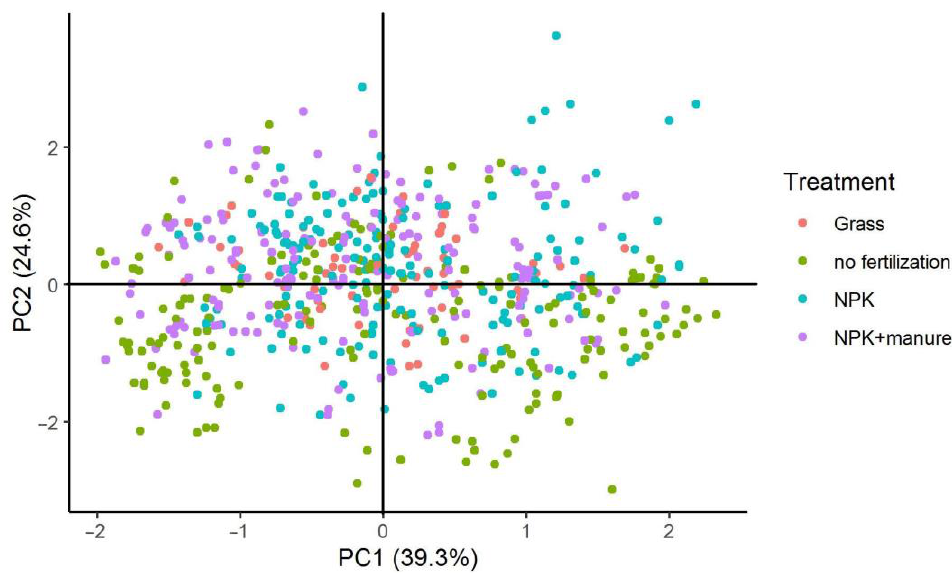
Figure 5. Principle component analysis (PCA) scores for components (PC) 1 and 2. The explained variance is in brackets. Colors highlight the land-use and nutrient-management effects. NPK: nitrogen, phosphorus, potassium fertilization.